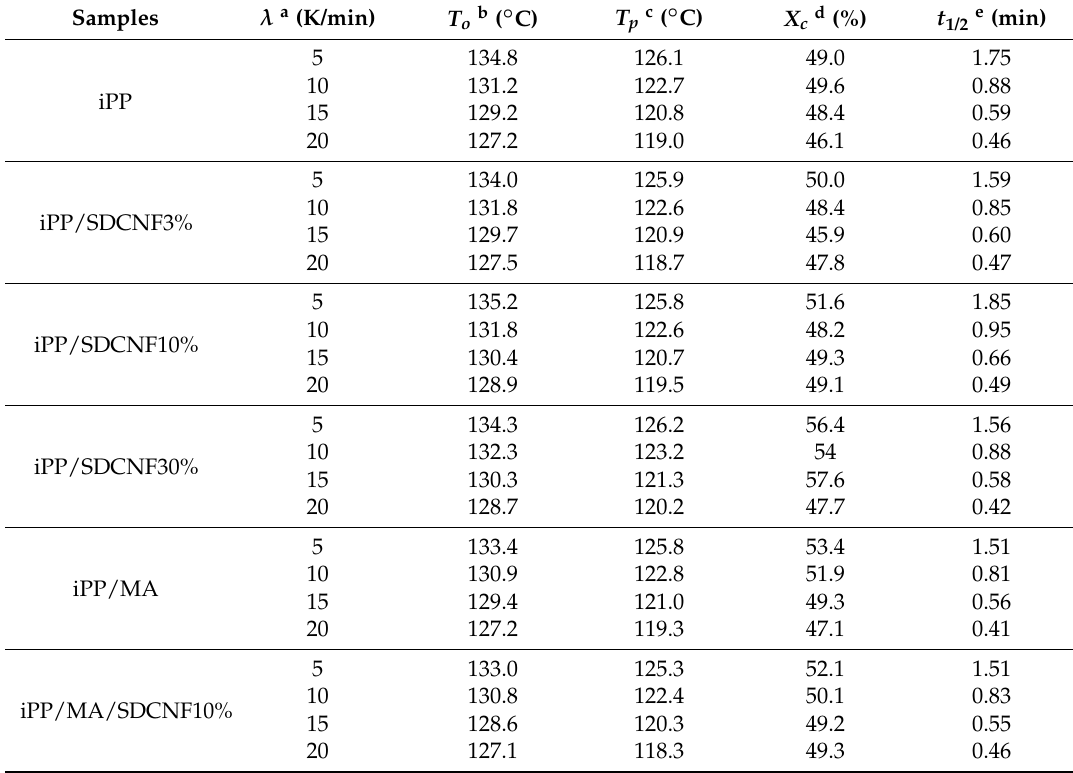
Table 3. Nonisothermal crystallization parameters at various cooling